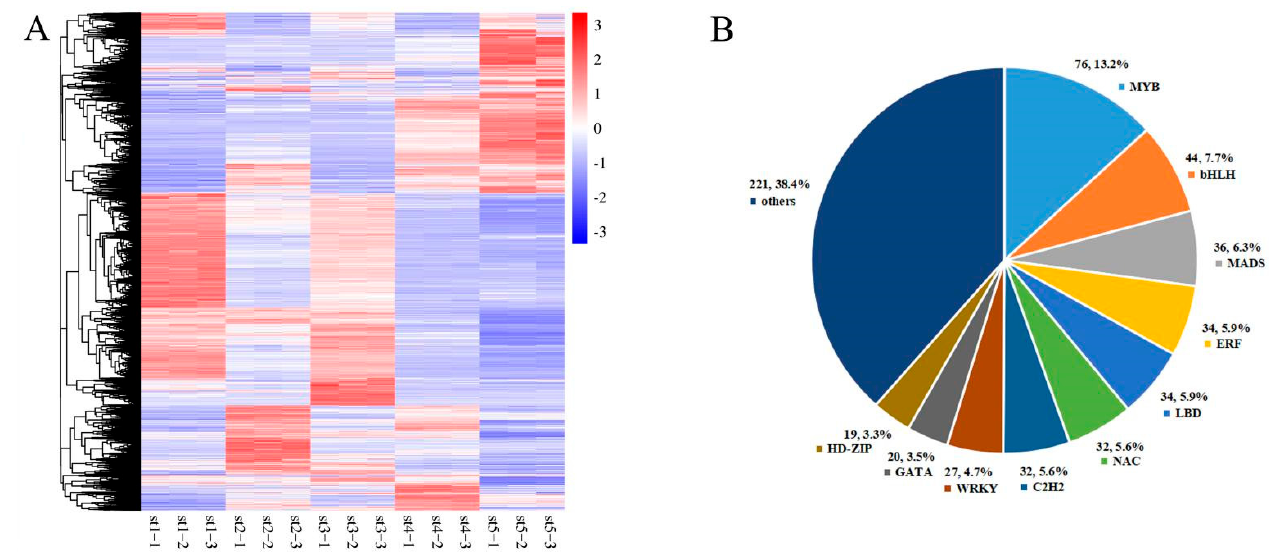
Figure 2. Summary of differentially expressed genes (DEGs). ( A ) Heat map of the total DEGs. Columns and rows in the heat map represent samples and genes, respectively. The colour gradient from blue to red indicates low to high expression levels. ( B ) The top ten percentages of differentially expressed transcription factors. Table 1. The number of differentially expressed genes in different developmental stages.